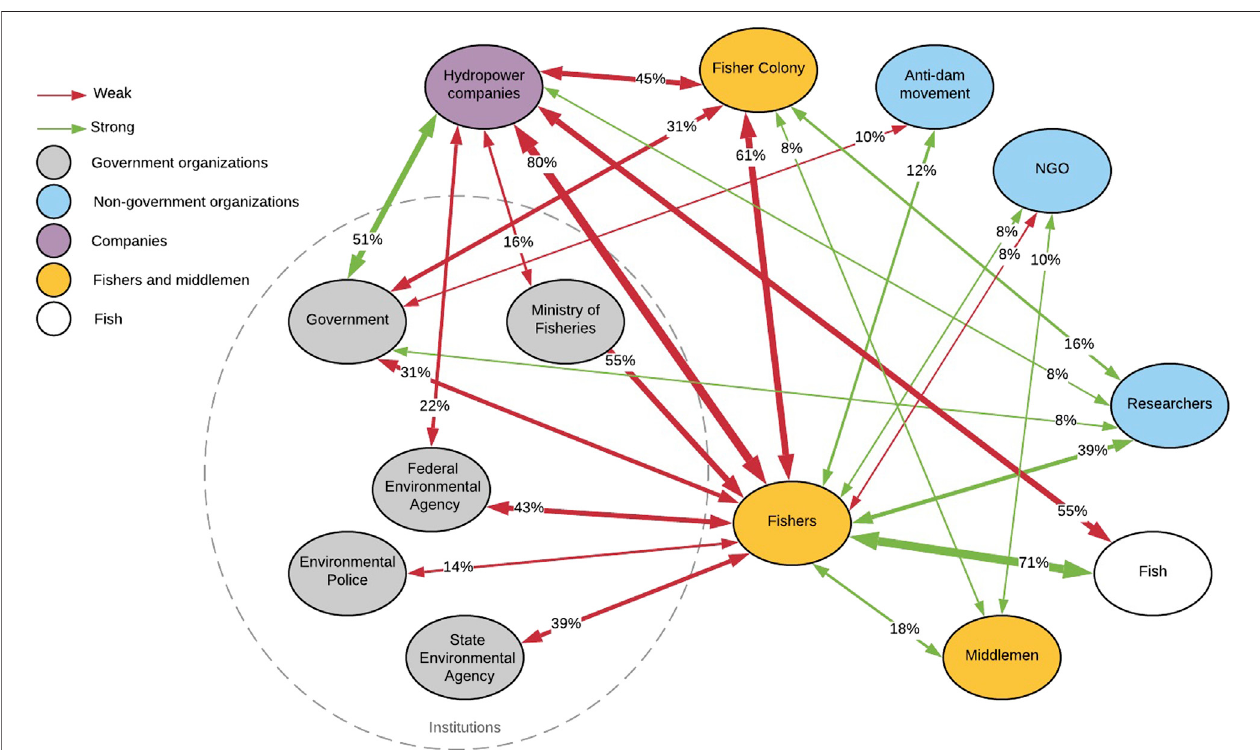
FIGURE4| CognitivemapoftheMadeiraFisheriesSystemafterimplementationoftheSantoAnt ˆ onioandJiraudams.Thecirclesrepresenttheinstitutionscitedby the respondents: the green lines represent strong relationships that contribute to sustainability, while red lines represent weak relationships that do not contribute to the fi shing sustainability. Line density represents the percentage of responses related to all